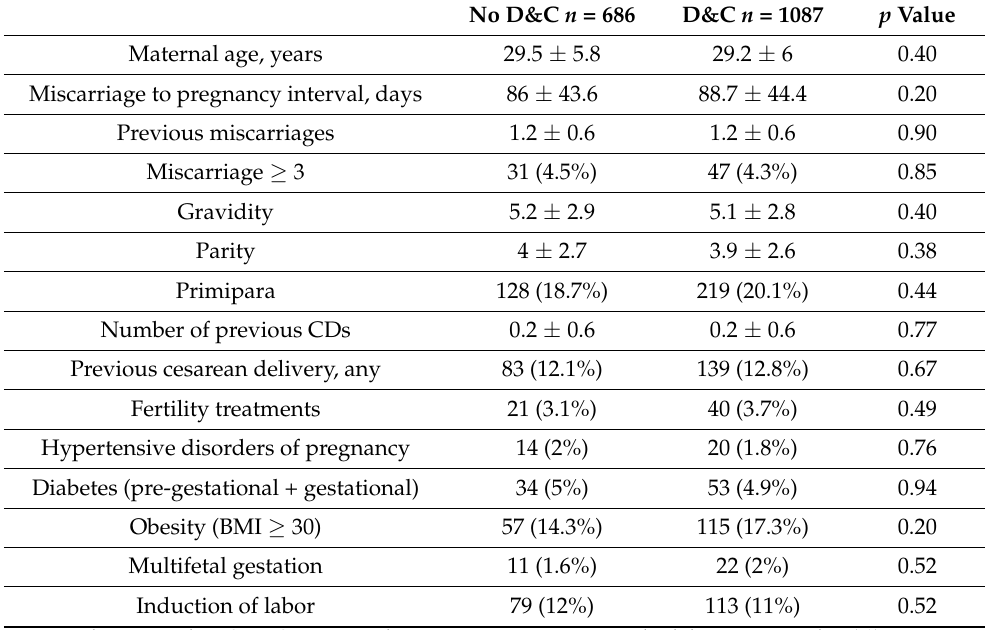
Table 1. Demographic and obstetric characteristics of the women stratified by the mode of uterine evacuation in the prior